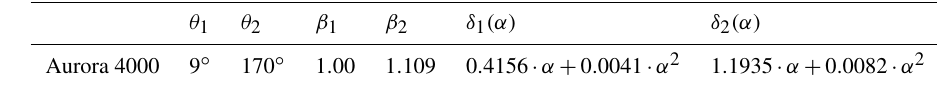
Table 1. Parameters of the Aurora 4000 angular sensitivity function given by Müller et al. (2012).